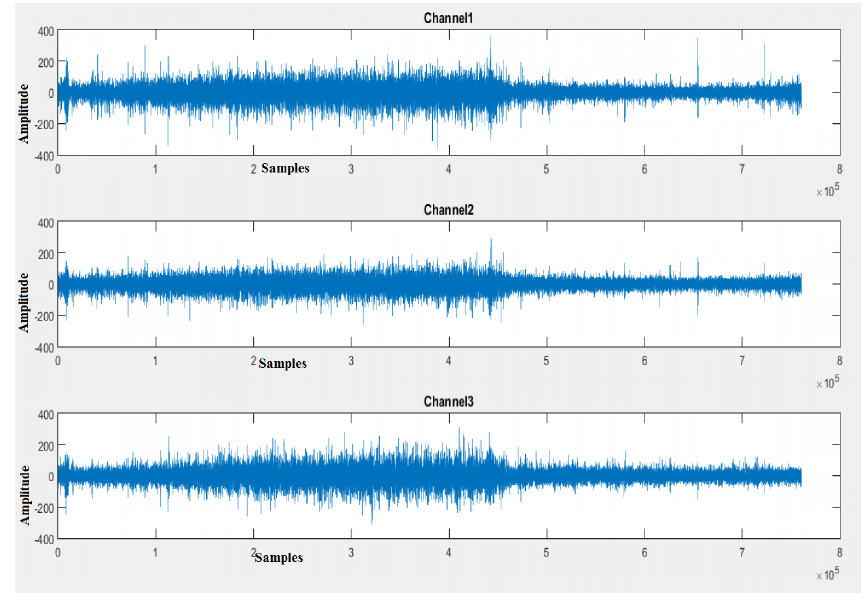
Figure 1. One hour recording of EEG signal of epileptic patient for three